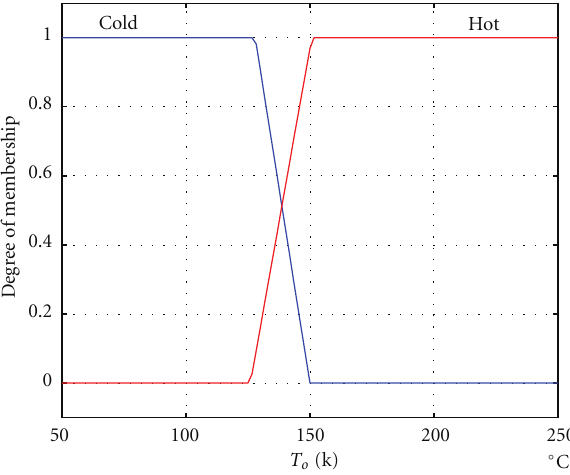
Figure 6: Membership function of the outside temperature.